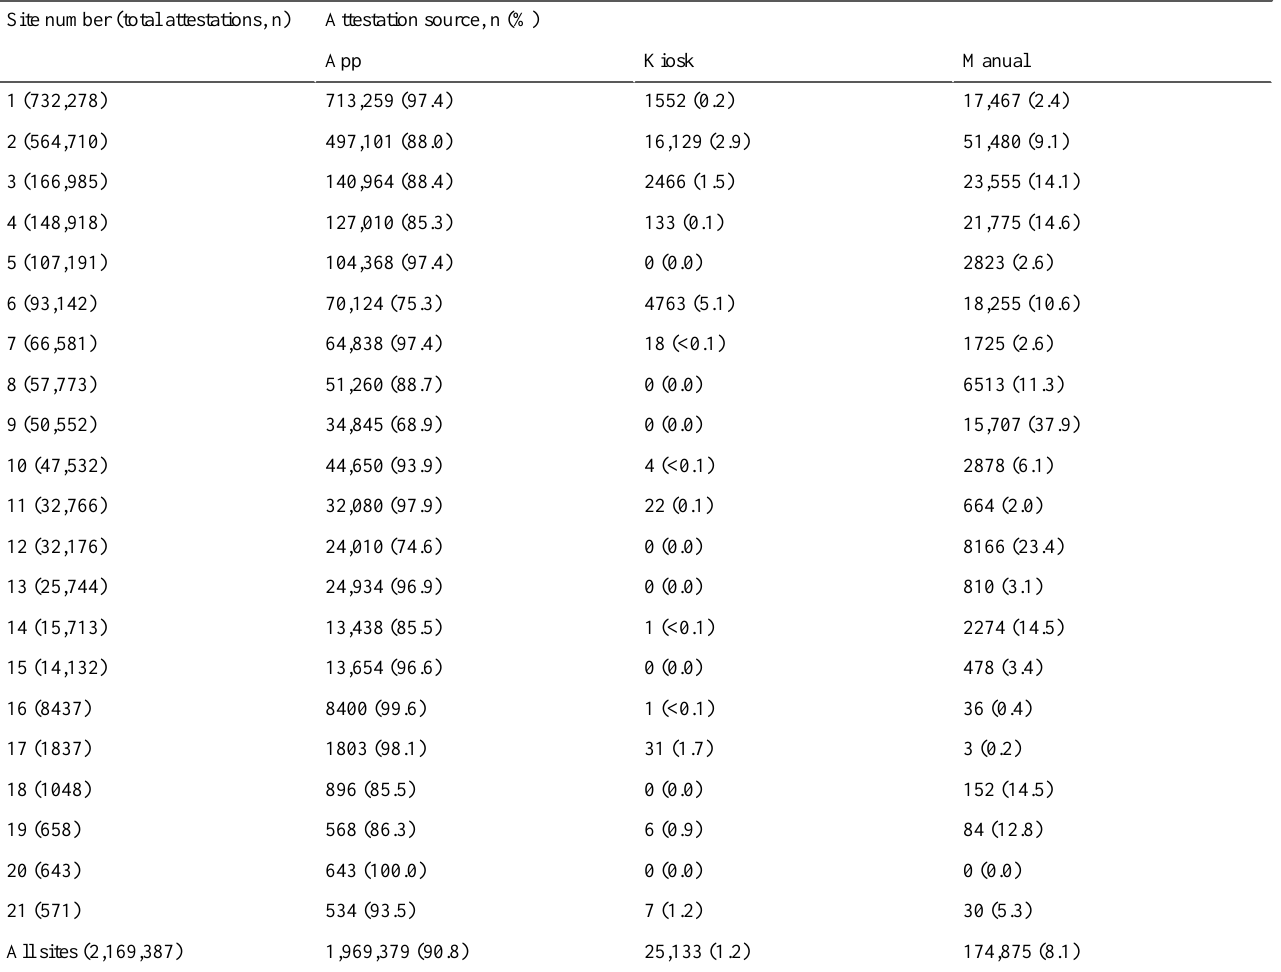
Table 1. COVID Pass attestations by employee app-based self-attestation, manual screening, and kiosk by site on March 30 to June 30, 2020 (N=2,169,387). Note that some sites used separate manual screening data collection methods; data for these sites are not reflected here. Attestation source, n (%)Site number (total attestations, n)